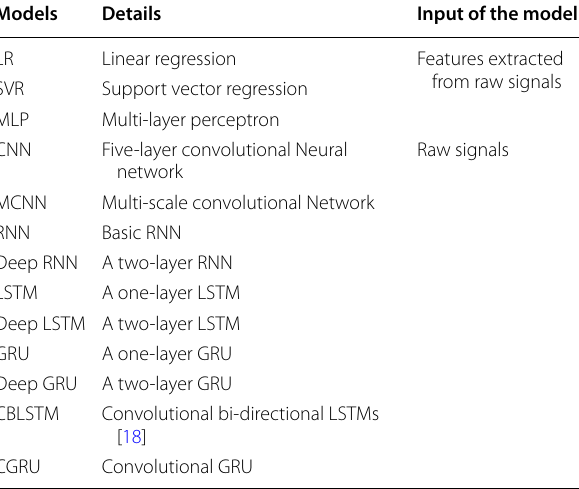
Table 2 Details of the compared models Models